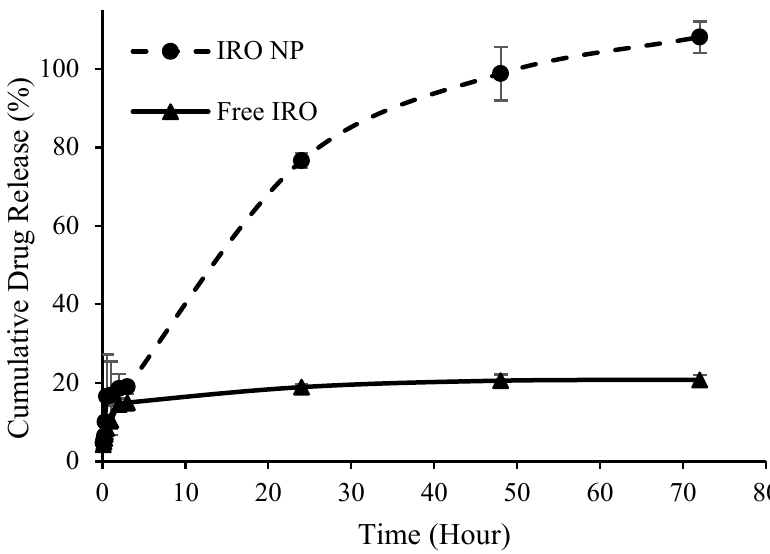
Figure 3. Cumulative Irosustat (IRO) release from PLGA NP over time versus free drug in DMSO.